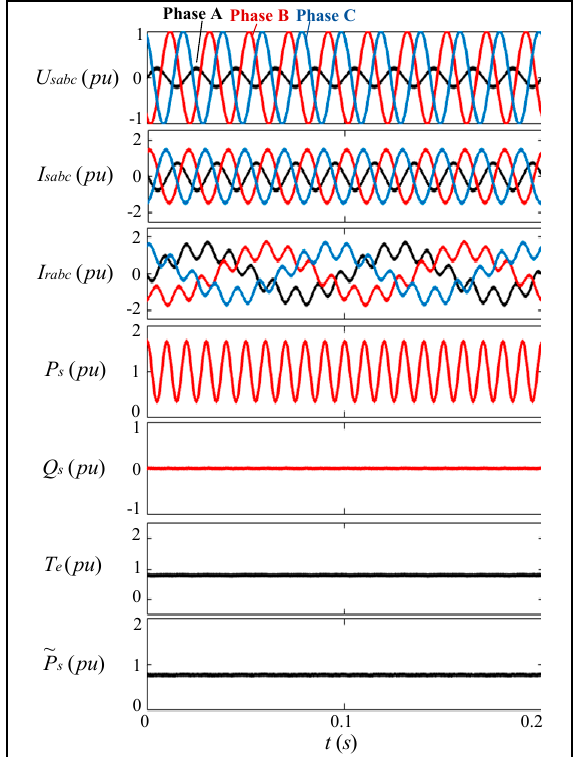
Figure 11. Proposed VSG control under a single-phase grid voltage drop of 80% (Target 1). Energies 2020 , 12 , x FOR PEER REVIEW